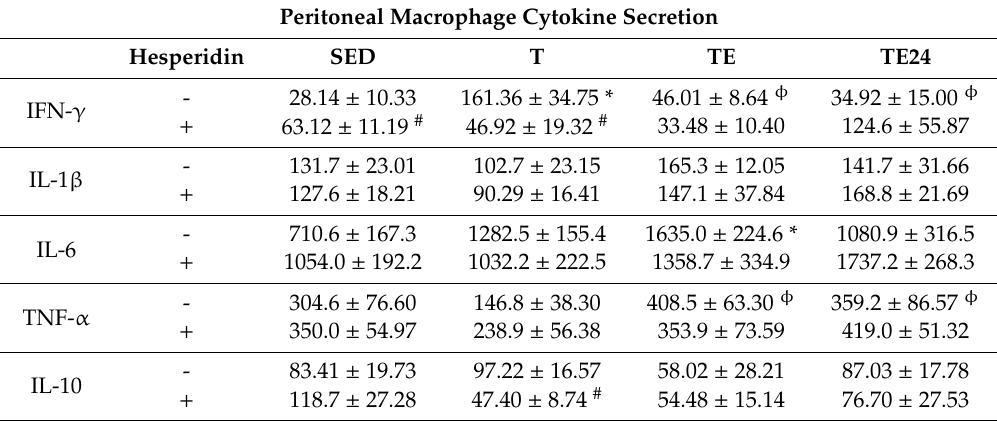
Table 3. Cytokine concentration (pg/mL) released by peritoneal macrophages stimulated by LPS. Peritoneal Macrophage Cytokine Secretion